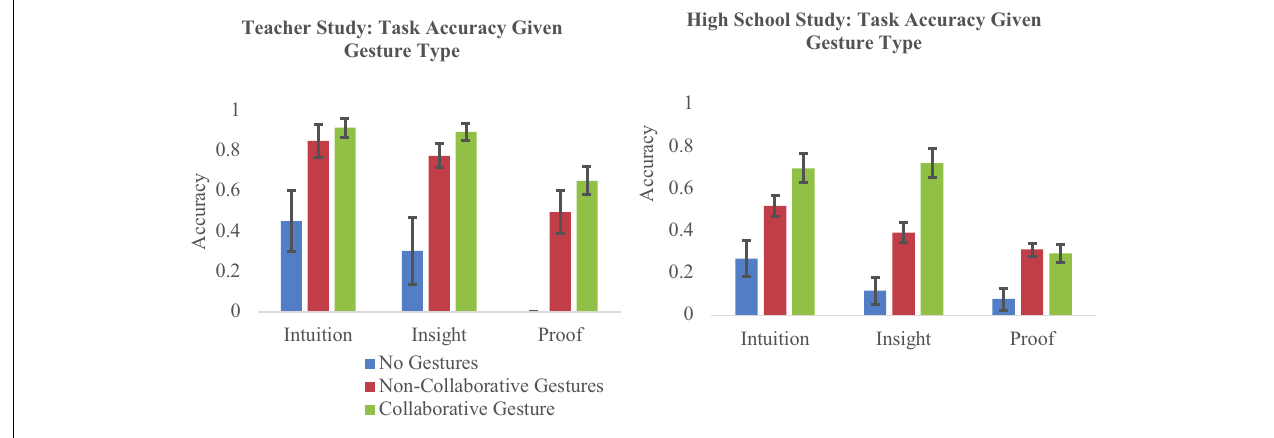
FIGURE 6 | Bar graphs depicting differences in performance when proving geometric conjectures depending on whether and how learners in a group